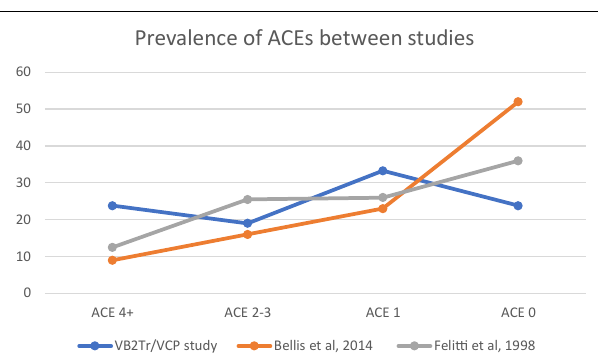
between the three groups in terms of the prevalence of ACEs, therefore, the directional hypothesis is not supported. Table 6 provides more descriptive data about the VB2Tr participant group relating to specific exposure to ACEs. The results focussed on exposure to physical abuse, physical neglect, mother physical abuse, and criminal behaviour in the